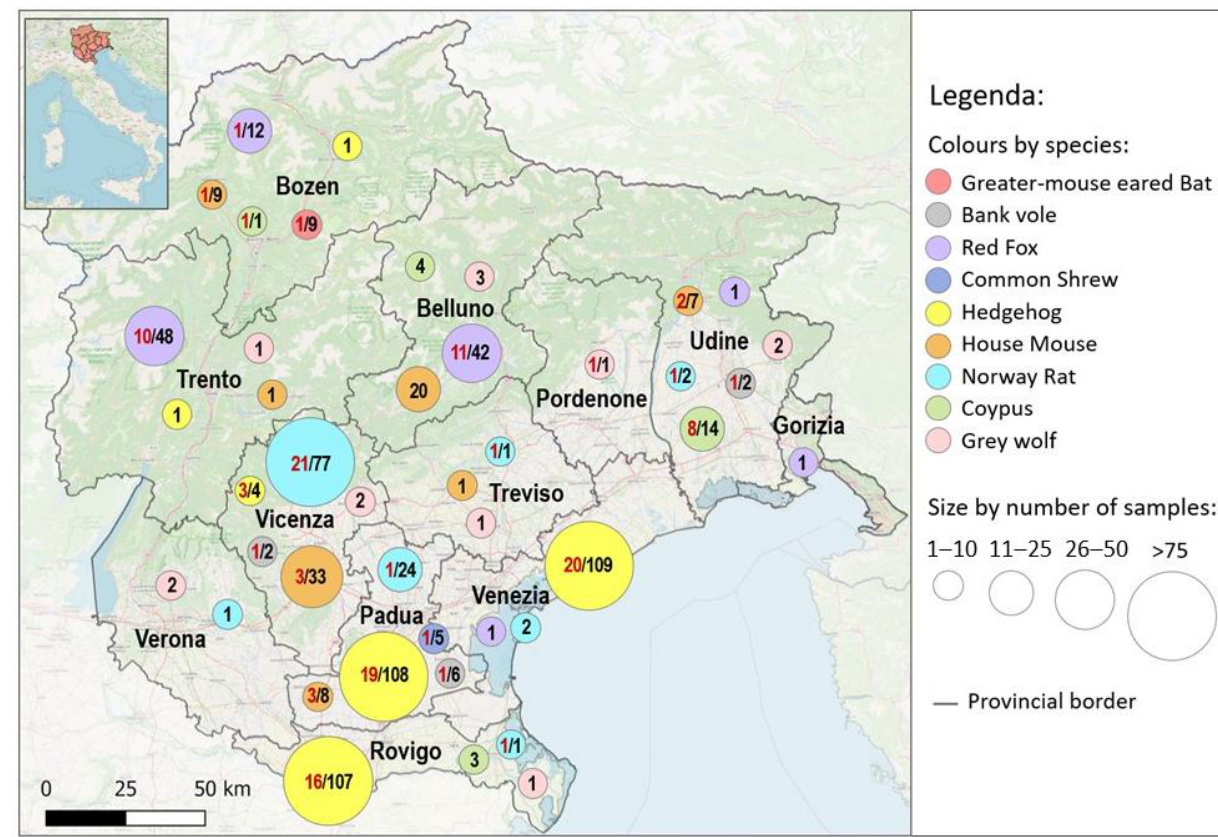
Figure 1. Synanthropic and wild animals analyzed for Leptospira spp. geographically mapped. The size of each dot changes according to the total number of samples examined, while the colors represent the different animal species, as indicated above. Black numbers indicate the total samples of each species analysed per province, while red numbers highlight the positive samples, when present.